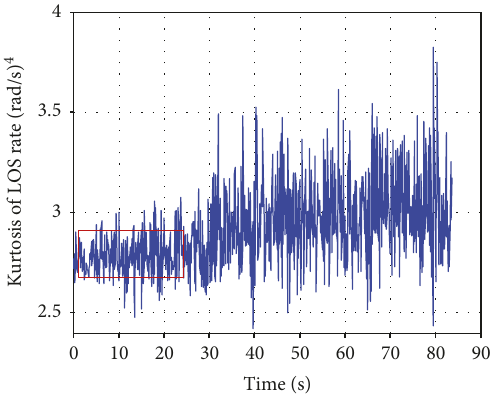
Figure 9: Kurtosis of the LOS rate.